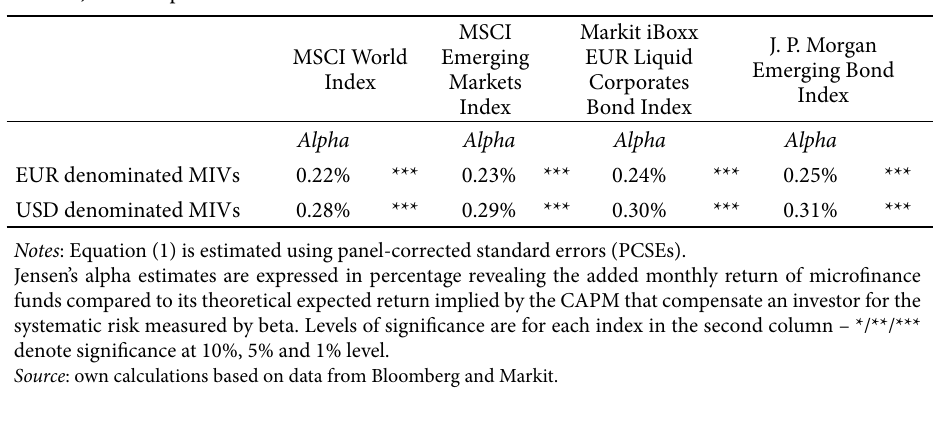
Table 6. Jensen’s alphas